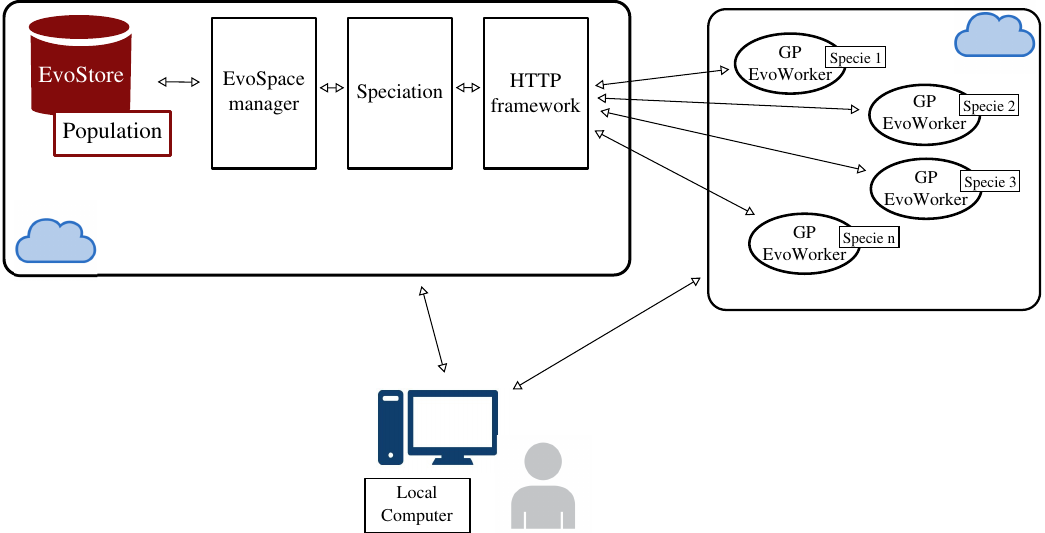
Figure 6. Implementation of the neat-GP-LS algorithm in EvoSpace, where the samples taken by each EvoWorker correspond to a complete